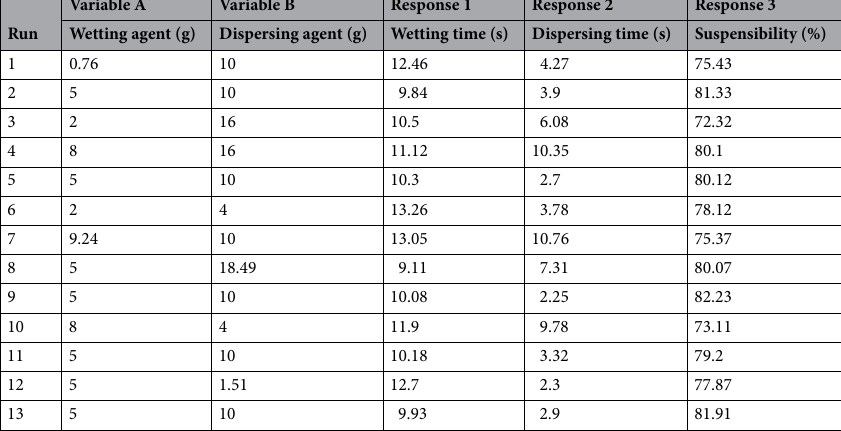
Table 1. Experimental design and results of central composite design for the development of efficient water dispersible